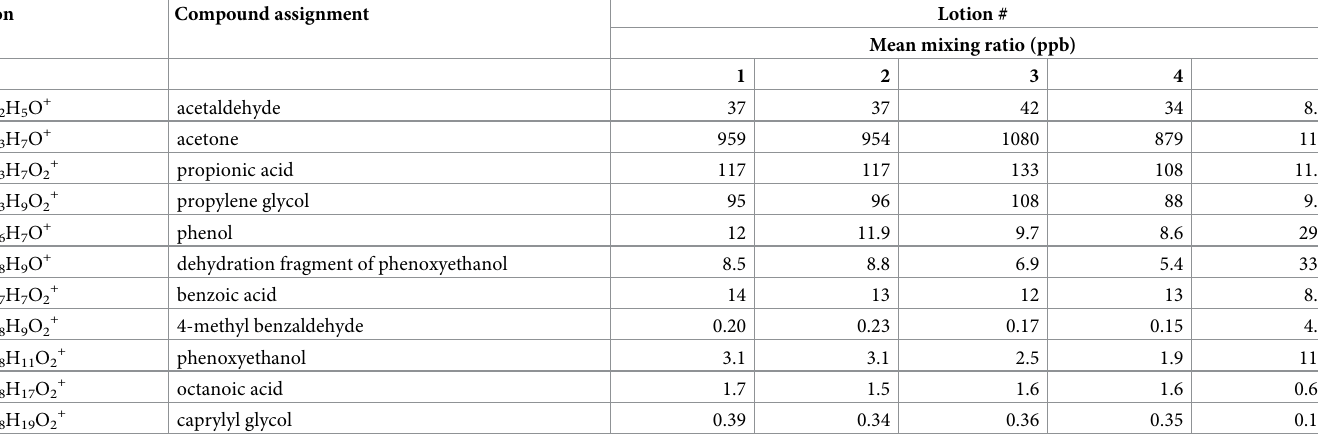
Table 2. Select ions associated with primary emissions from lotions. Mixing ratios (ppb) shown have baseline (bare skin) values subtracted (by subject), then averaged.